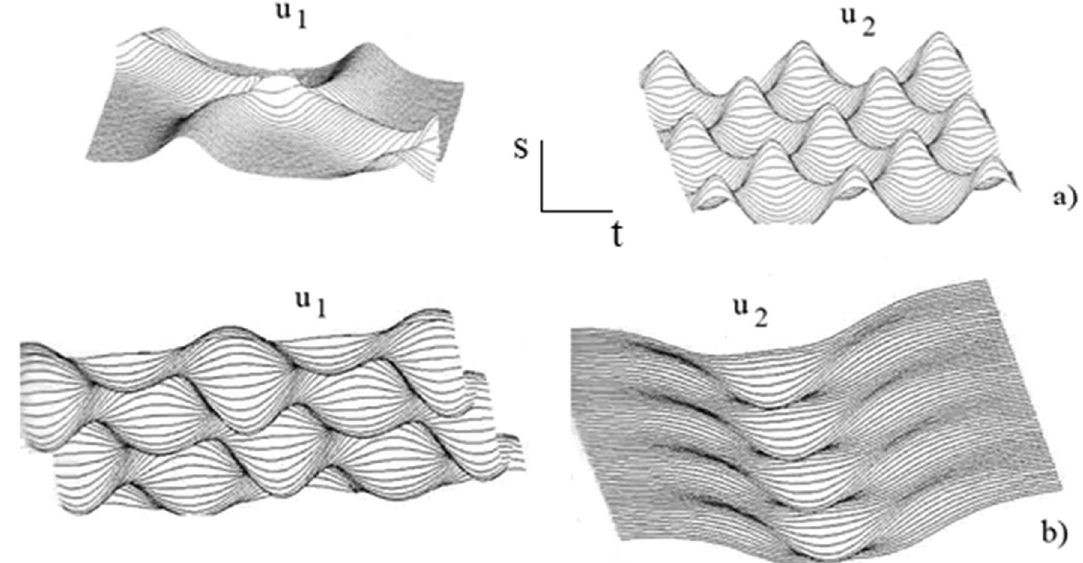
Figure 5. Functions u 1 and u 2 for ( a ) the first route and ( b ) the second route.